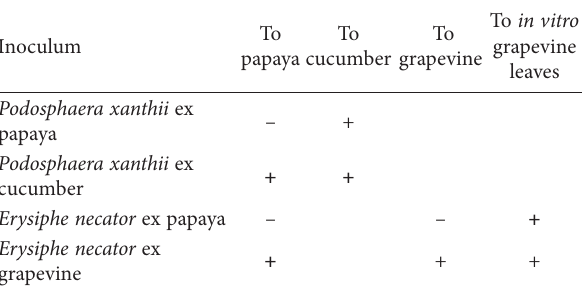
Table 2. Summary of cross inoculation test results. (+) denotes suc- cessful infections and (–) denotes no infection.